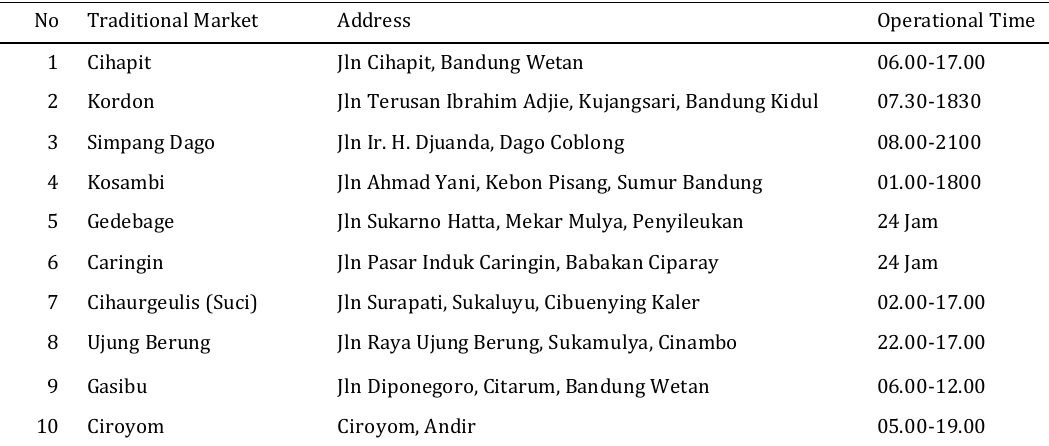
Table 5 Vegetables Produced by Bandung